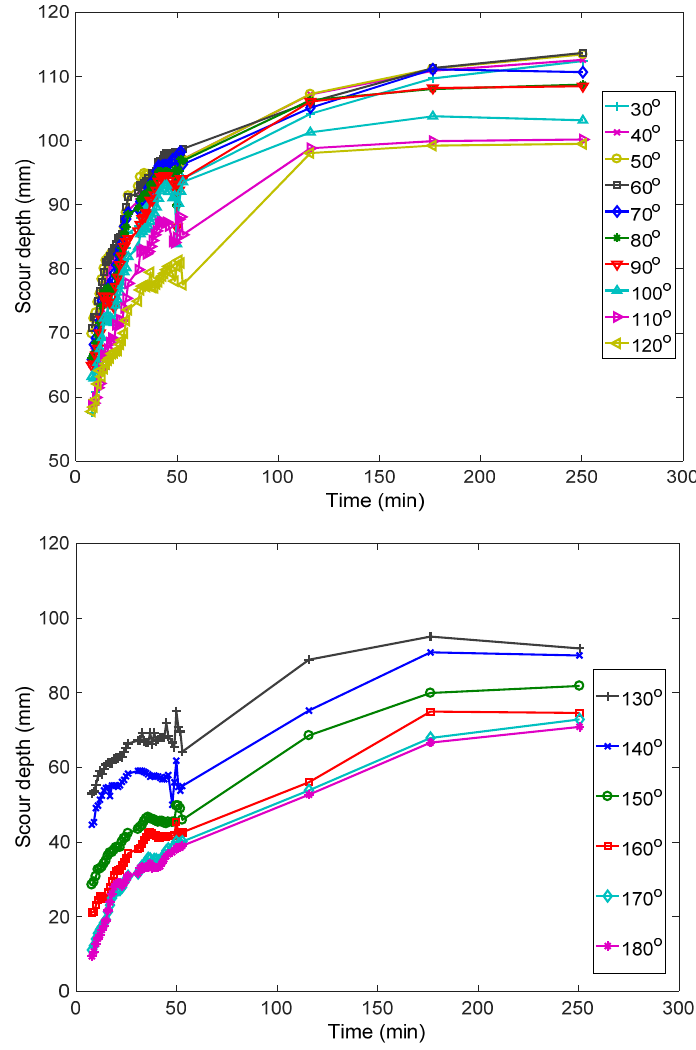
Figure 8. Temporal evolution of scour at locations with r = 10 mm and θ ranging from 0° to 180°. The time-averaged slope of every radial profile, after t = 9 min was found from the instantaneous linear fits of the radial profiles (as shown in Figure 9). The results are plotted in Figure 10. It is shown that the average slopes at different angular planes vary significantly. They increase from θ = 0 ◦ to θ = 40 ◦ and then they decrease from θ = 40 ◦ to θ = 110 ◦ . Also, the time-averaged slopes at approximately 35 ◦ ≤ θ ≤ 55 ◦ are higher than the estimated angle of repose (35 ◦